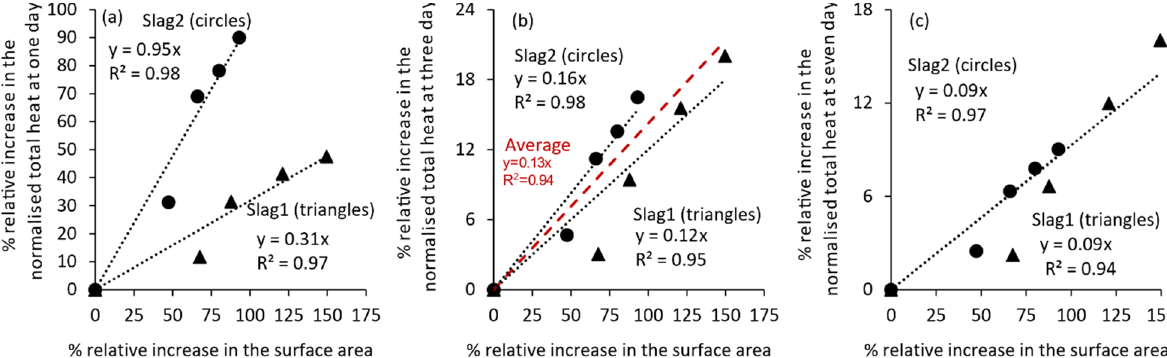
Figure 6. % relative increase in the total heat recorded at (a) one day, (b) three days and (c) seven days with the % relative increase in the surface area of the activated slag1 (triangles) and slag2 (circles)